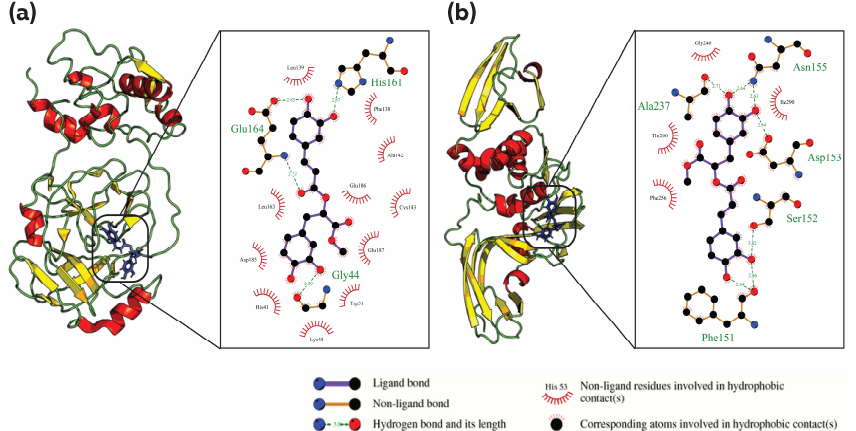
Figure 1. Analysis of protein–ligand interaction for Methyl rosmarinate (PubChem CID: 6479915) against Mpro and PLpro; Analysis of the binding pocket and types of interaction between ( a ) 6479915 and Mpro, ( b ) 6479915 and Plpro. The figure illustrates the 3D and 2D binding modes of Methyl rosmarinate with the key amino acid residues of the Mpro and Plpro.